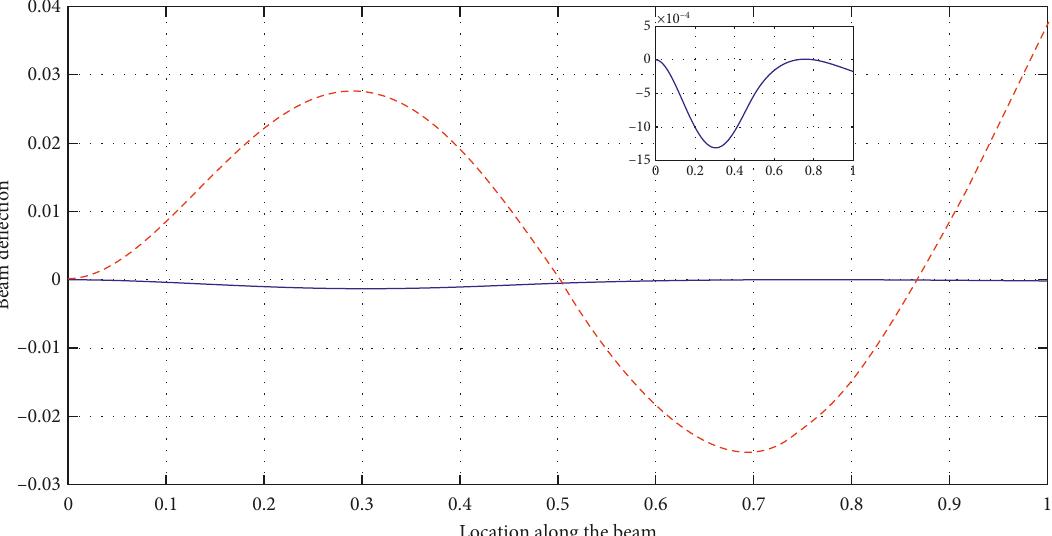
Figure 6: The steady-state deformed shape of a collocated controlled (solid line) and uncontrolled (dashed line) undamped cantilever beam when ω � 61.68, x f � 0.5, x n � 0.8, and x a � 0.3. The small figure shows a detailed plot of the controlled shape.